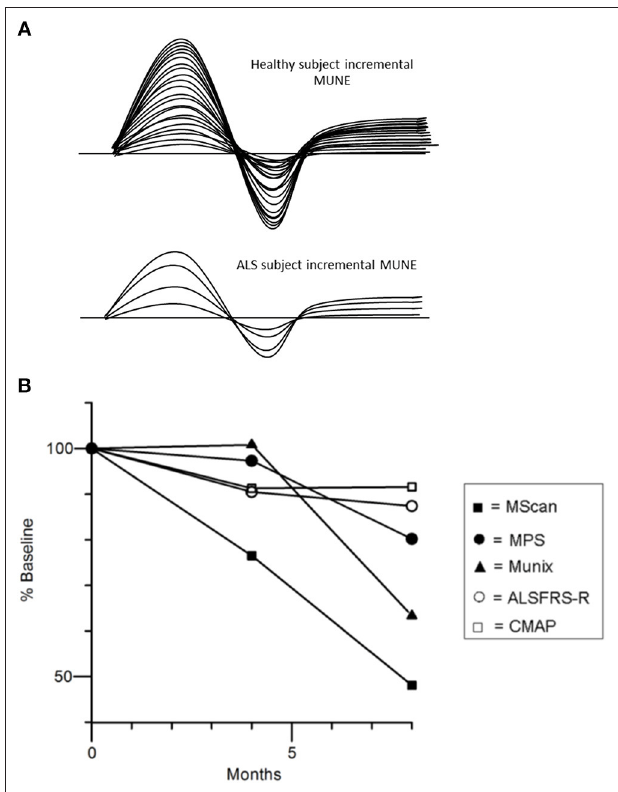
FIGURE 4 | (A) Incremental MUNE in healthy and ALS subjects, demonstrating a large number of “steps” with increasing stimulus intensity consistent with a large number of functioning motor units within measured muscle, whilst there were only four steps in the ALS subject indicating only four functional motor units remaining in muscle. (B) Percentage changes in MUNE values (geometric means) and mean ALSFRS-R and CMAP amplitude at 4 and 8 months. Reproduced with permission license no. 4457481173441 (